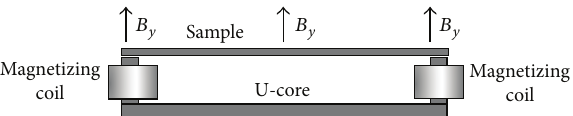
Figure 7: Measurement of 𝐵 𝑦 component of the magnetic flux leakage with sample between core legs without cracks.